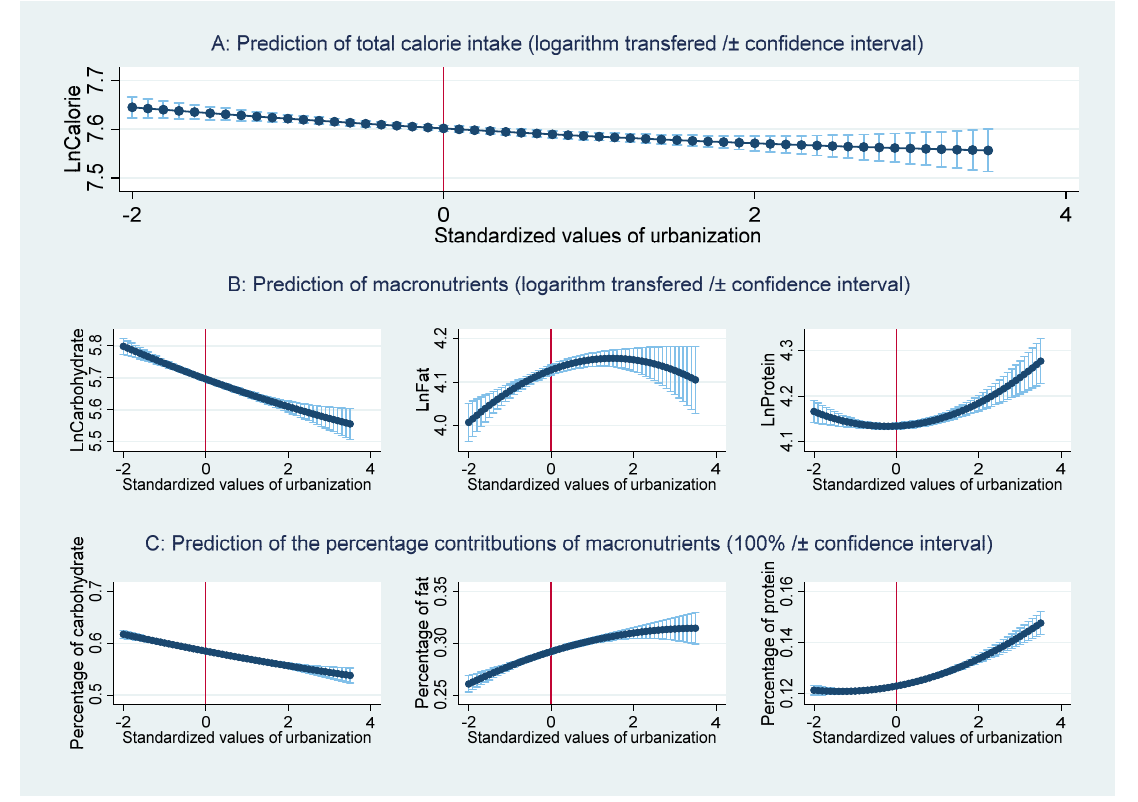
Figure 2. The relationship between urbanization and the predicted nutrition intakes and their percentage contributions. Table 5. The effect of urbanization on the Healthy Eating Index